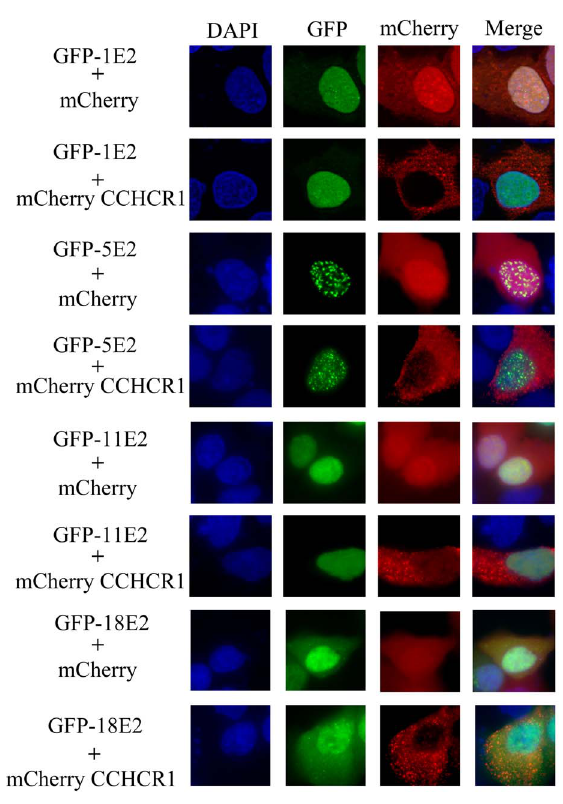
Figure 5. CCHCR1 does not affect the distribution of non- interacting E2 proteins. HaCaT cells were co-transfected with the expression plasmids for GFP or the indicated GFP-E2 proteins, and mCherry-CCHCR1 or mCherry alone and processed as in Figure 4. Four E2 proteins (HPV1, 5, 11 and 18) not able to interact with CCHCR1 were studied, and no change in their subcellular localization could be observed in the presence of CCHCR1.